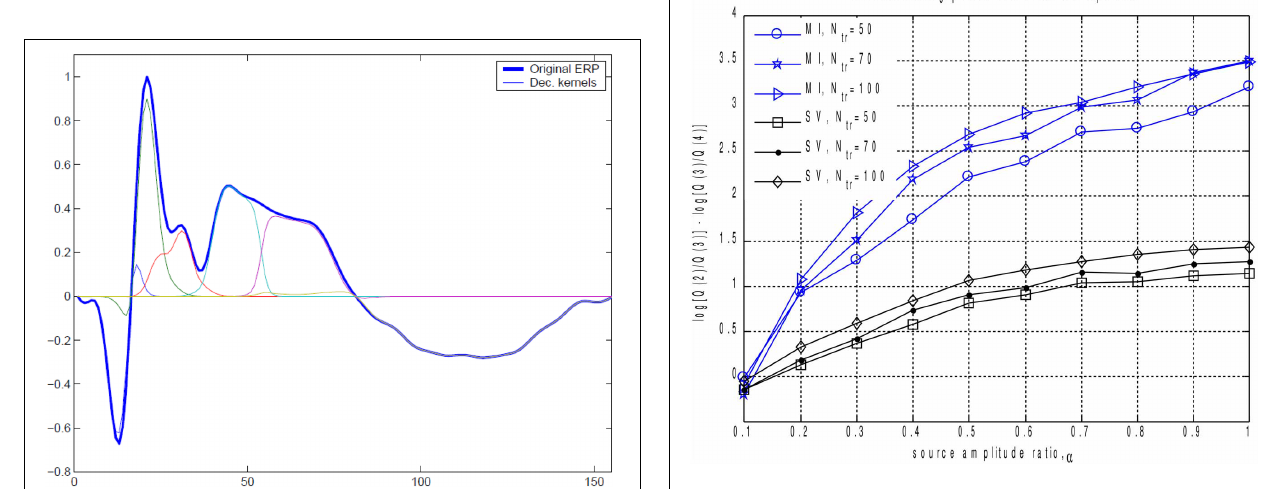
FIGURE 3 | To simulate trial-to-trial variation of the responses we used overlapping Gaussian kernel based model. At each trial we varied relative positions of the kernel centers, kernel amplitudes, and global response latency with respect to the binary stimulus signal. A typical response and its representation with a set of overlapping modulated kernels is shown.